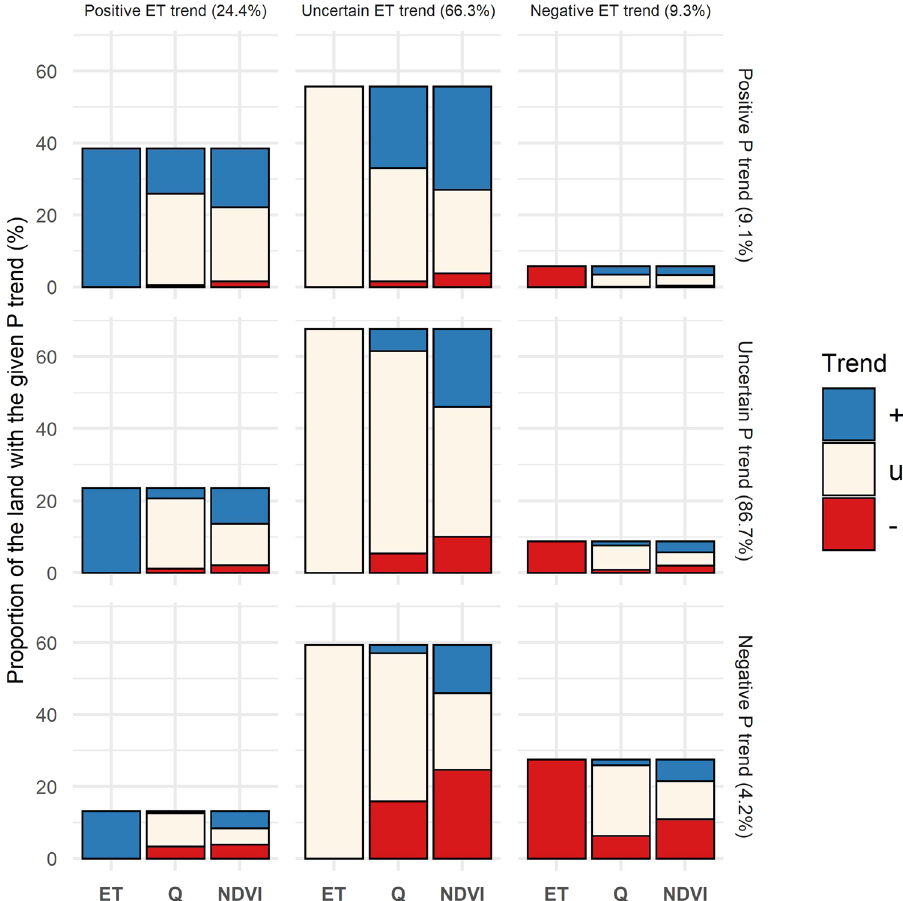
Fig. 3 Spatial analysis of directional change in trends of P , ET, Q and NDVI. Percentage of land area displaying positive, negative, and uncertain trends in P (columns), and in each case, proportion of land displaying positive, negative, and uncertain trends in ET, and corresponding Q , and NDVI trends (rows). Uncertain trends include uncertain positive, uncertain negative and inconclusive